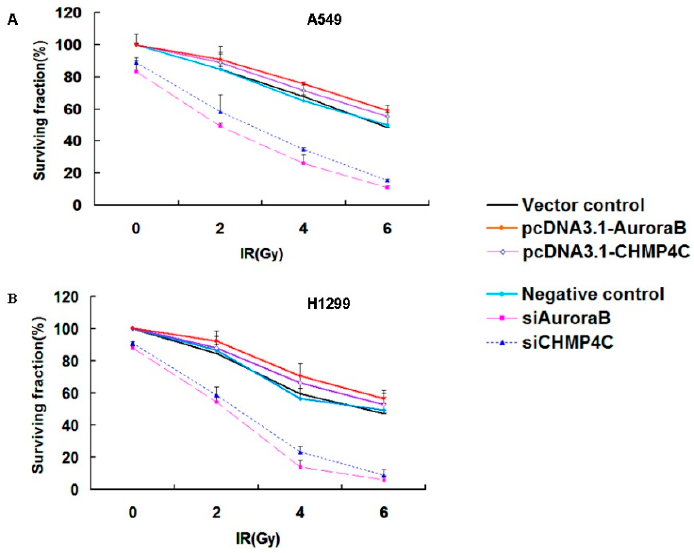
Figure 4. CHMP4C and Aurora B increase radioresistance. ( A ) A549 or ( B ) H1299 cells were transfected with siRNAs or plasmids for 24 h before exposed to 2, 4, and 6 Gy-irradiation. One thousand cells per plate were seeded immediately after IR and incubated for 14 days. Colonies were stained with 1% crystal violet. The number of colonies was counted and surviving fraction was calculated as the mean number of colonies/(cells seeded × plating efficiency). The data are expressed as the mean ± S.E. of three independent experiments.